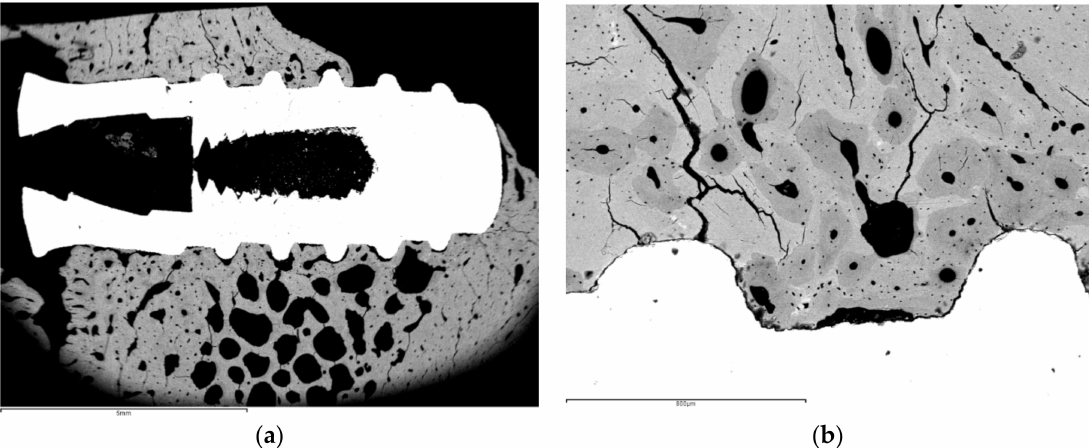
Figure 13. Histology at 2 weeks after implantation. ( a ). Dental implant with an osseointegration of approximately 70% after two weeks of implantation. ( b ). At higher magnification showing the implant-bone tissue